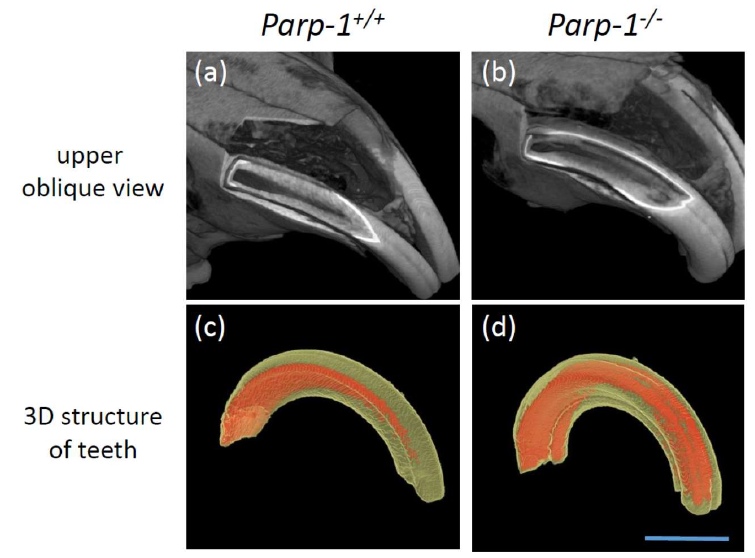
Figure 4. ( a ) Upper oblique view of Parp-1 +/+ mouse and ( b ) upper oblique view of Parp-1 −/− mouse via 3D images. ( c ) Three-dimensional structure of Parp-1 +/+ mouse incisor. ( d ) Three-dimensional structure of Parp-1 −/− mouse incisor. Hard tissue (enamel and dentin) is drawn in yellow and pulp cavity is drawn in orange. Bar indicates 2 mm.